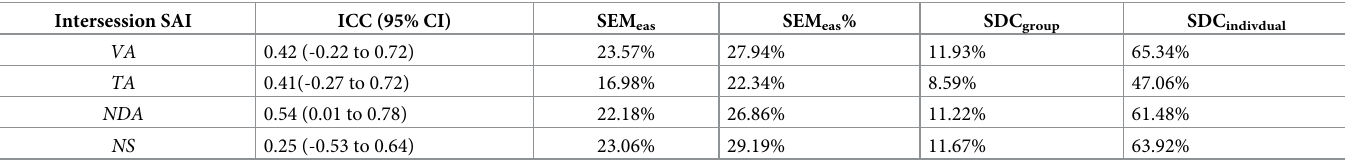
Table 3. Intersession reliability statistics SAI. SEM eas , SDC individual, SDC group are expressed as a percentage of the unconditioned MEP. In contrast, %SEM eas is expresses the SEM eas as a percentage of the mean.